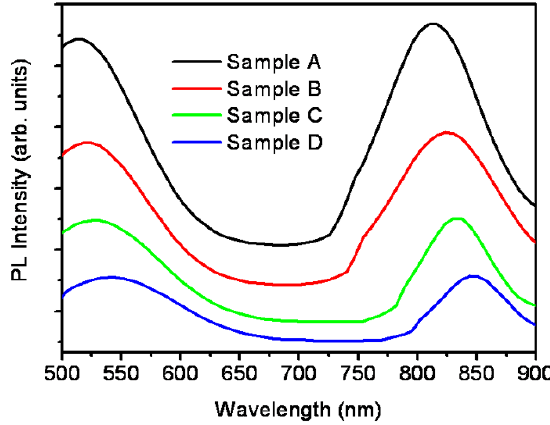
Figure 8. PL spectra of as-deposited and RTA porous GaAs.